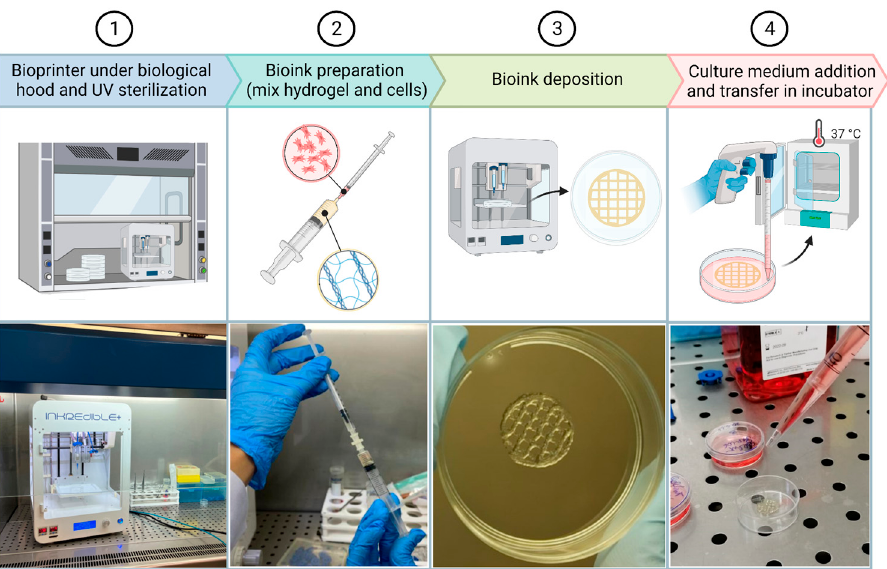
Figure 10. Three-dimensional-bioprinting procedure. It starts with ( 1 ) the positioning of the bi- oprinter under a biological hood and UV light sterilization. ( 2 ) Next, bioink is prepared by mixing cells and hydrogel and ( 3 ) finally printed. ( 4 ) Culture medium is added and 3D structures are placed inside the incubator.